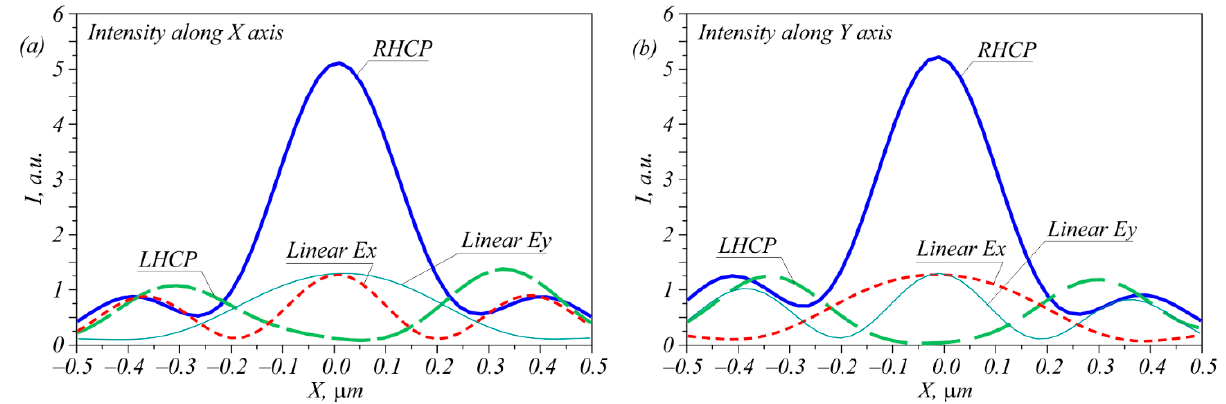
Figure 3. Intensity profiles for all four polarizations along the X ( a ) and Y ( b ) axes. As can be seen in Figures 2 and 3, all four polarizations generated focal spots that differed in both the shape and the amplitude. Right circular polarization generated a circular focal spot (Figure 2b) with a diameter at the half-maximum intensity equal to FWHM = 0.427 λ . Left circular polarization generated in the metalens focused (Figure 1) a light ring with a radius of 0.31 µ m and a ring thickness of 0.4 λ . When focusing a linearly polarized light, an elliptic focal spot was generated with the widths at half-maximum intensity equal to FWHM = 0.32 λ along the small axis of the ellipse and FWHM = 0.68 λ along the large axis of the ellipse. Note that the light ring shown in Figure 2a was not smooth because the transmittance function of the inclined diffraction gratings did not have a constant